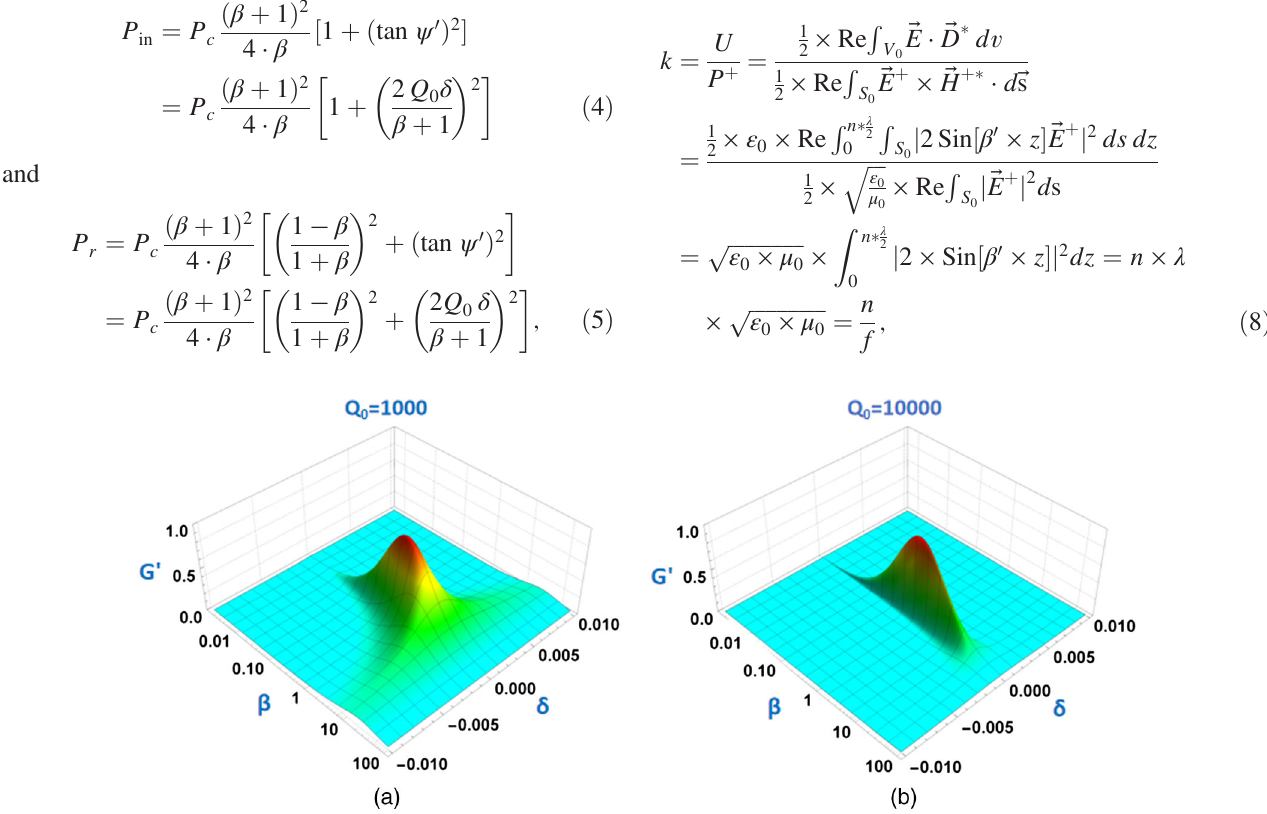
FIG. 2. The normalized power gain of the test scheme, with (a) at Q 0 ¼ 1000 , and (b) at Q 0 ¼ 10000